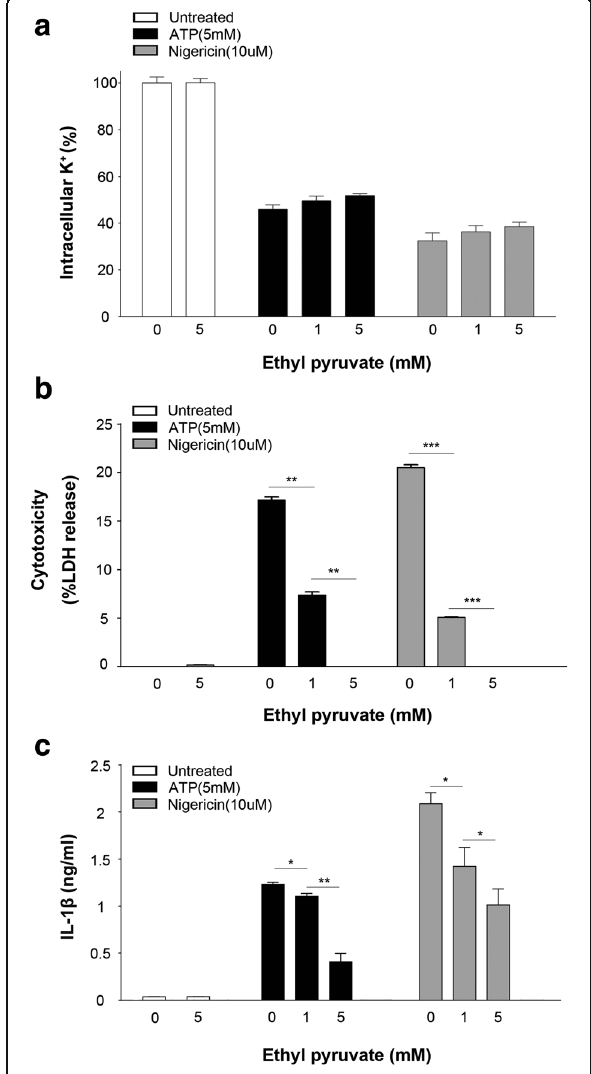
Fig. 3 Inhibition of NLRP3 activation by EP is independent of potassium efflux. Peritoneal mouse macrophages were primed with ultra-pure LPS (1 μ g/ml) for 3 h. with or without the presence of EP (1 or 5 mM), and then stimulated with ATP (5 mM) or nigericin (10 μ M) for 30 min. a Intracellular K+ concentration was measured. b Cytotoxicity was assessed by lactate dehydrogenase (LDH) cytotoxicity assay. c Levels of IL-1 β in the culture medium was determined by